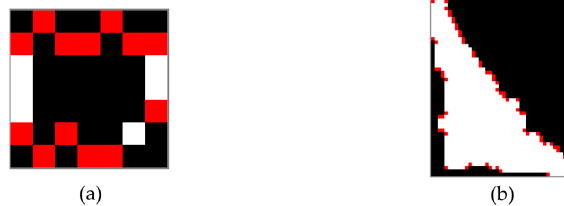
Figure 15. Detected vertices: ( a ) Vertices of Figure 14a; ( b ) Vertices of Figure 13d.